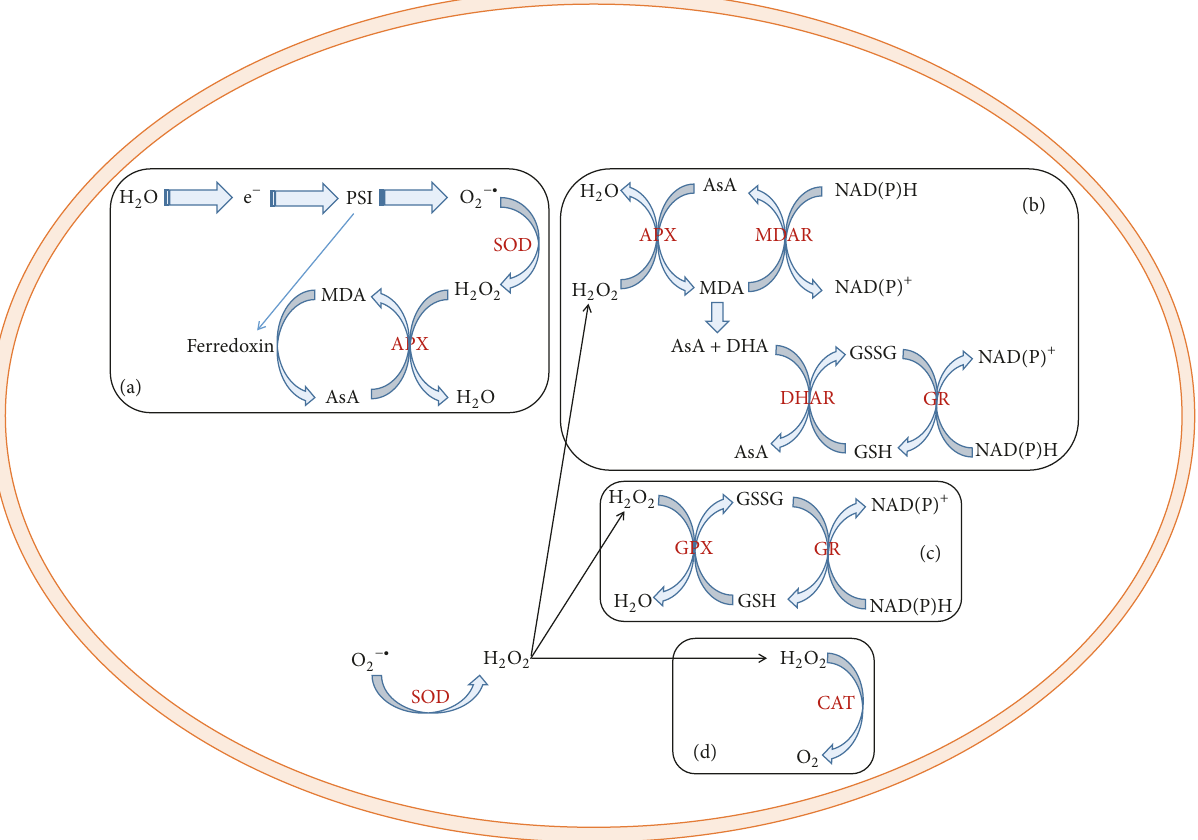
Figure 5: Reactive oxygen intermediates- (ROIs-) scavenging pathways in plant [77]. (a) Water-water cycle, (b) ascorbate-glutathione cycle, (c) glutathione-peroxidase (GPX) cycle, and (d) catalase (CAT). Enzyme abbreviations are as follows: APX, ascorbate peroxidase; AsA, ascorbic acid; SOD, superoxide dismutase; DHA, dehydroascorbate; DHAR, dehydroascorbate reductase; GR, glutathione reductase; GSH, glutathione; GSSG, oxidized glutathione; H 2 O 2 , hydrogen peroxide; MDA, monodehydroascorbate; MDAR, monodehydroascorbate reductase; PSI, photosystem